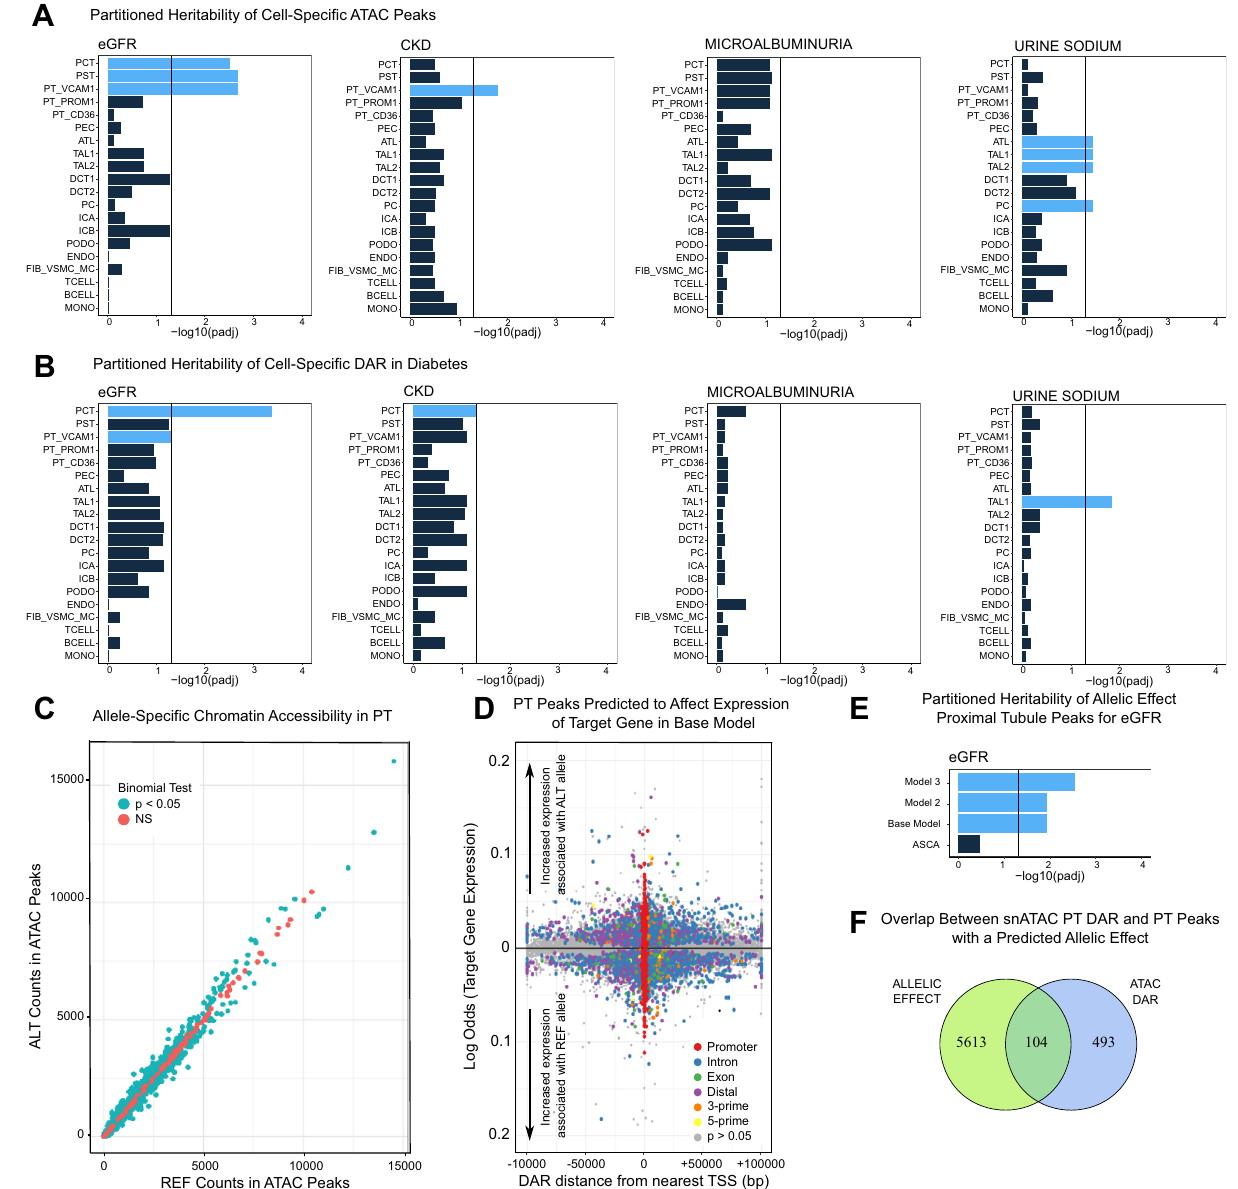
Fig.7|PartitionedheritabilityofGWAStraitsandpredictedalleliceffectswith SALSA. A Cell-speci fi c analysis. Cell-type-speci fi c ATAC peaks (Supplementary Dataset 2) were partitioned for heritability of GWAS traits using the ldsc cell-type- speci fi c work fl ow. Signi fi cance was evaluated with a Benjamini-Hochberg-adjusted